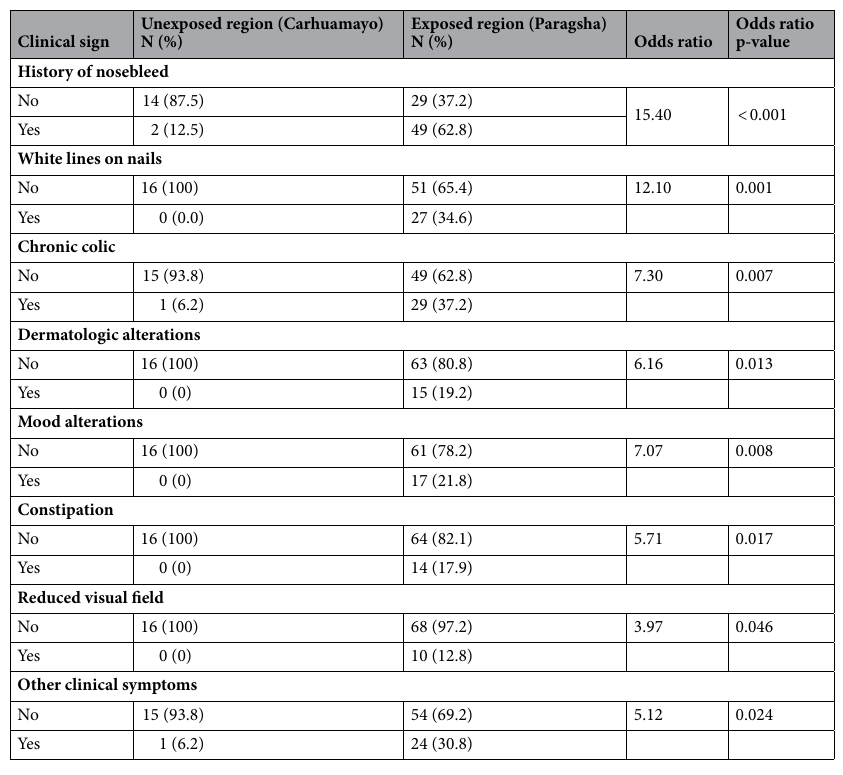
Table 5. Association between place of residence and manifestation of certain clinical signs. N number of children, X 2 chi-square test. Dermatologic alterations include café-au-lait spots in flexor areas of the abdomen, back, chest or neck, calluses on palms of the hands, soles with thick and rough skin and calluses in areas without friction; other clinical symptoms encompassed bluish line on the gum, calluses in body areas without friction, calluses on palms and sole with thick and rough skin and inflamed